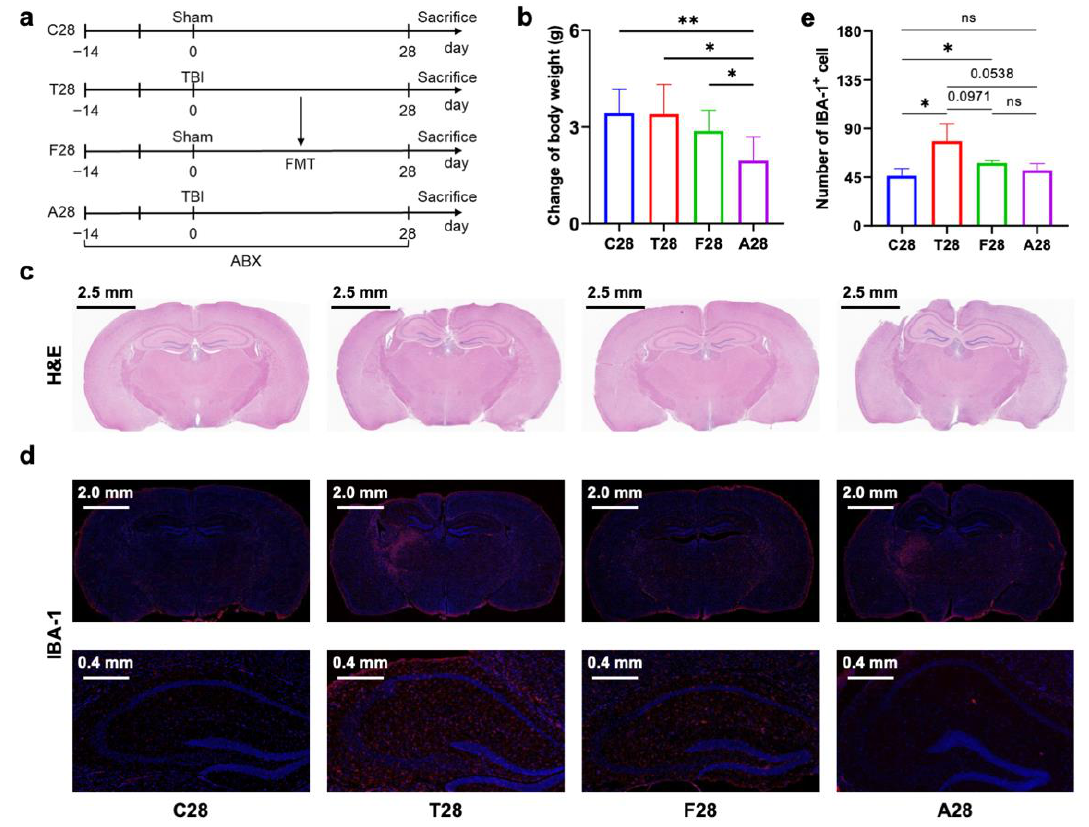
Figure 2. Design of the experiment and evaluation of brain injury and microglial activation at 28 days post-TBI. ( a ) Design of the experiment ( n = 6 per group). Mice of group C28 received sham surgery, mice of group T28 were subjected to TBI surgery without perioperative antibiotic treatment, mice of group F28 underwent sham surgery and FMT using fecal microbiota from the mice of group T28, and the mice of group A28 were subjected to TBI surgery with perioperative antibiotic treatment. All mice were sacrificed 28 days after TBI for sample collection. ( b ) Change of body weight before and after TBI ( n = 6 per group). ( c ) Representative images of brain H&E staining ( n = 3 per group). ( d ) Representative images of brain IBA-1 immunofluorescence staining (red) ( n = 3 per group). ( e ) The number of IBA-1 positive cells in the hippocampus. Data are shown as mean ± SD. * p < 0.05, ** p < 0.01 using unpaired Student’s t test. TBI, traumatic brain injury; H&E, hematoxylin–eosin; IBA-1, ionized calcium-binding adapter molecule 1; ns, no significant.